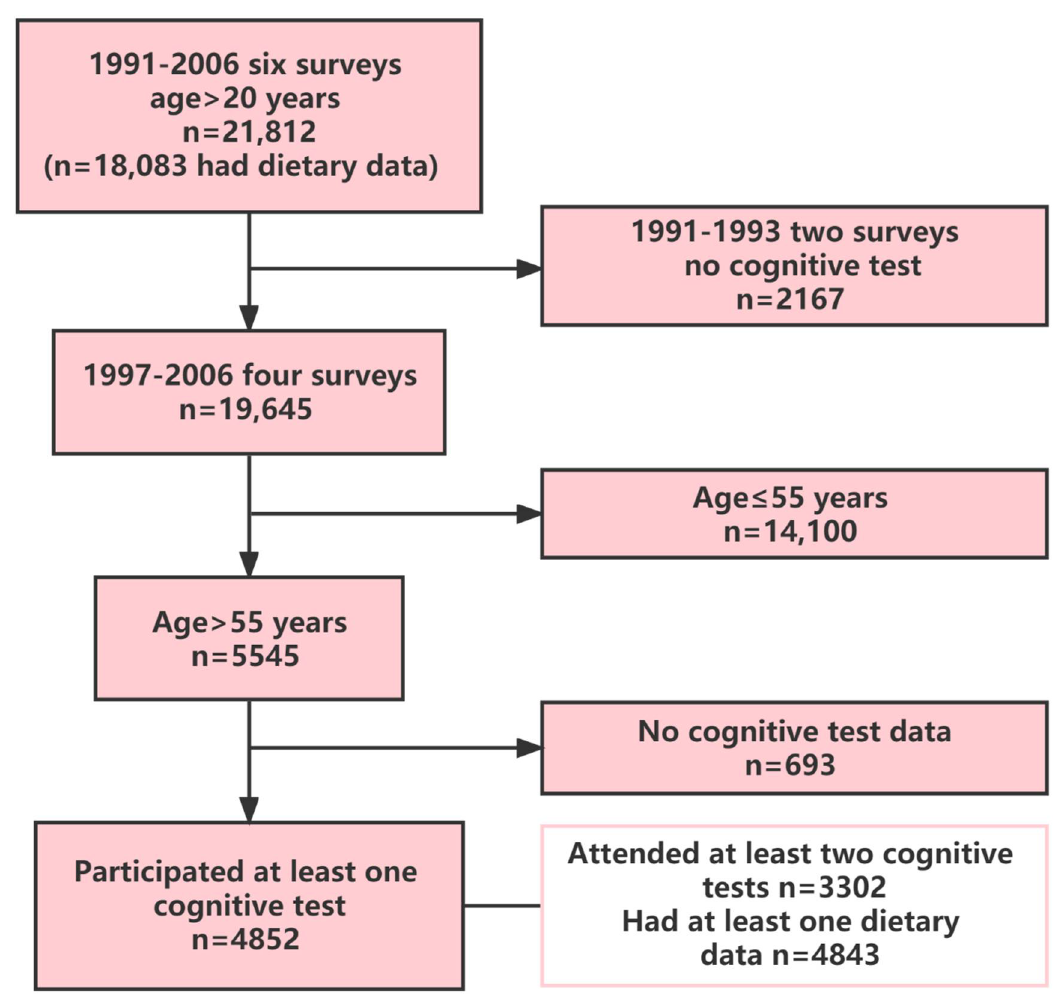
Figure 1. Sample flowchart of participants attending the China Health and Nutrition Survey.